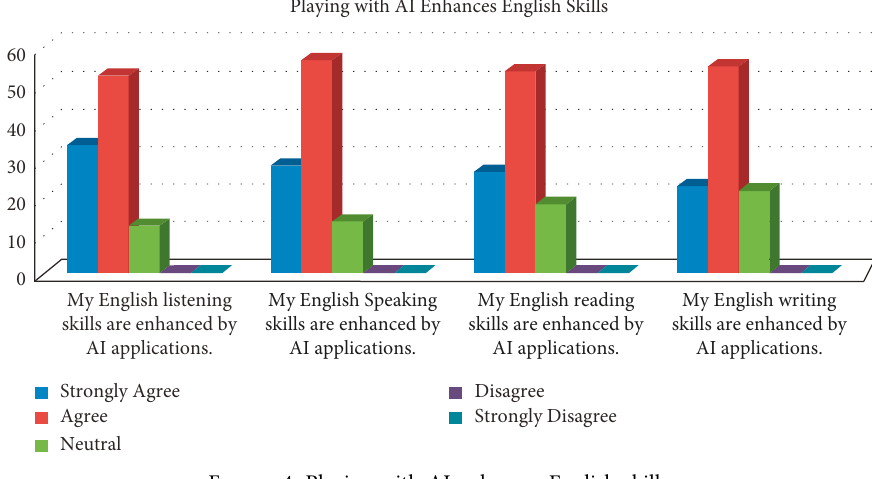
Figure 4: Playing with AI enhances English